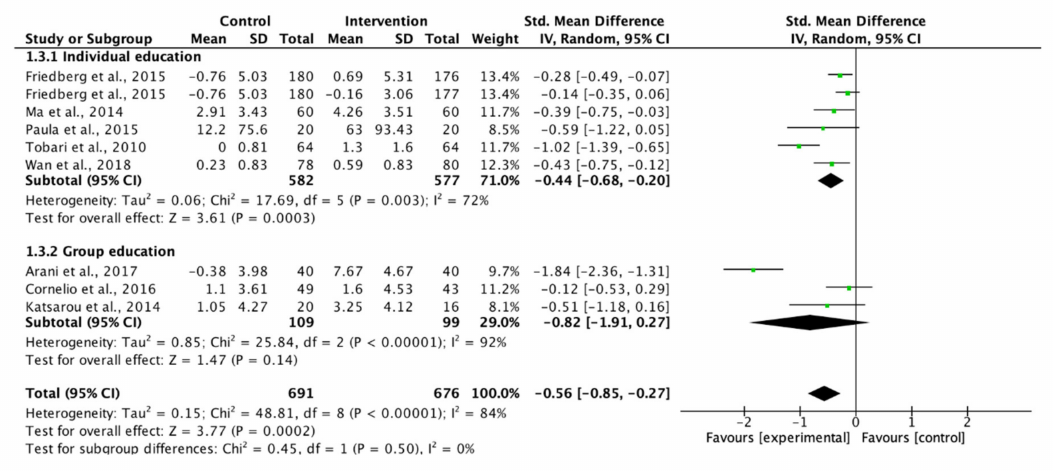
Figure 4. Forest plot of di ff erent educations on adherence to dietary recommendations.